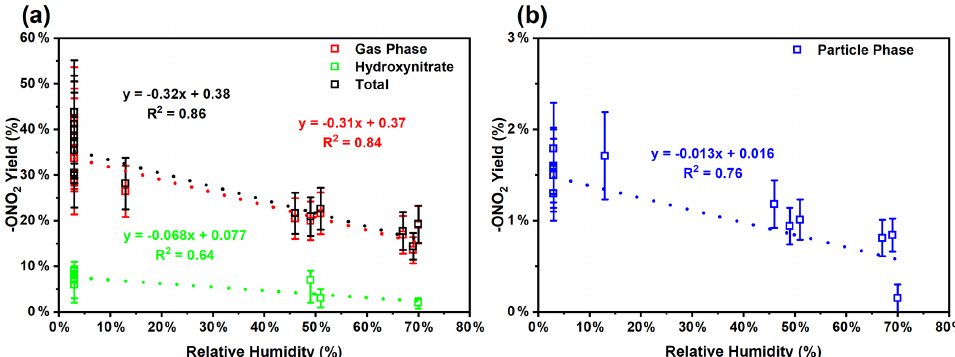
Figure 3. (a) Wall loss and dilution-corrected total gas-phase organic nitrate (-ONO2), total (both gas- and particle-phase) organic nitrate (quantified by FTIR), and hydroxy nitrate (quantified by CIMS) yield at different RH. (b) Wall loss and dilution-corrected total particle-phase organic nitrate yield at different RH. Error bars represent the propagated analytical uncertainty of the